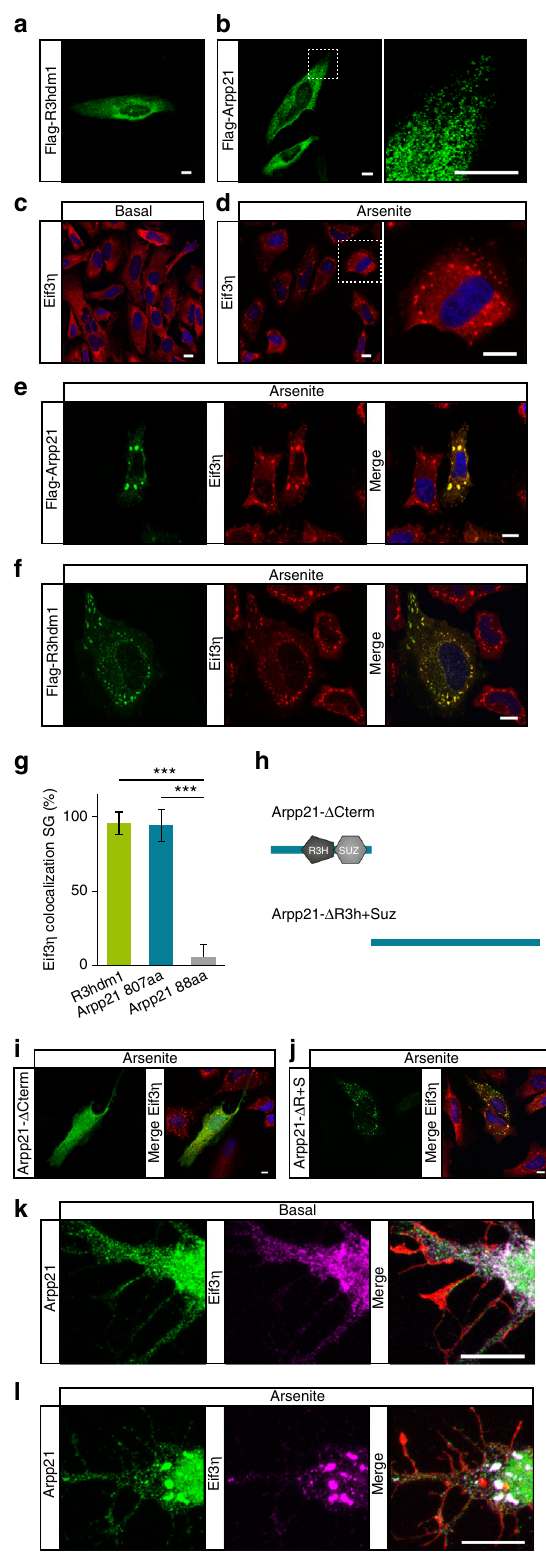
Fig. 2 R3HDM1 and ARPP21 localize to the cytosol and show overlapping staining with the stress granule marker eIF3 η in response to stress. a , b FLAG immunostainings of HeLa cells expressing N-terminally FLAG-tagged R3HDM1 or ARPP21 reveal cytosolic localization in small, perinuclear- enriched granules. The right panel in b shows a higher magni fi cation of the dotted box in the left panel. c Diffuse, cytosolic staining of the stress granule marker eIF3 η is visible under basal conditions. d Treatment of HeLa cells with arsenite induces stress granules positive for eIF3 η . e , f ARPP21 and R3HDM1 colocalize with eIF3 η upon arsenite stimulation. g Quanti fi cation of eIF3 η colocalization with R3HDM1 and the two ARPP21 protein isoforms. Data expressed as mean ± s.d. R3HDM1: n = 94 cells. ARPP21-807aa. n = 89 cells. ARPP21-88aa: n = 141 cells. *** p < 0.001, Student ’ s t -test. h Schematic depiction of ARPP21 truncation mutants used in i and j . i ARPP21 lacking its C-terminal region (green) shows no colocalization with eIF3 η (red) upon cellular stress. j Upon cellular stress localization of the C-terminal ARPP21 construct lacking N-terminal domains (green) overlaps with eIF3 η (red). k , l Staining of endogenous ARPP21 (green), eIF3 η (magenta), and phalloidin (red) in cultured primary cortical neurons after 4 days in vitro (DIV4). k Under basal conditions ARPP21 localizes to neuronal cell bodies and proximal dendrites. l Upon arsenite treatment ARPP21 colocalizes with the SG marker eIF3 η . Scale bar in all images: 10 µ